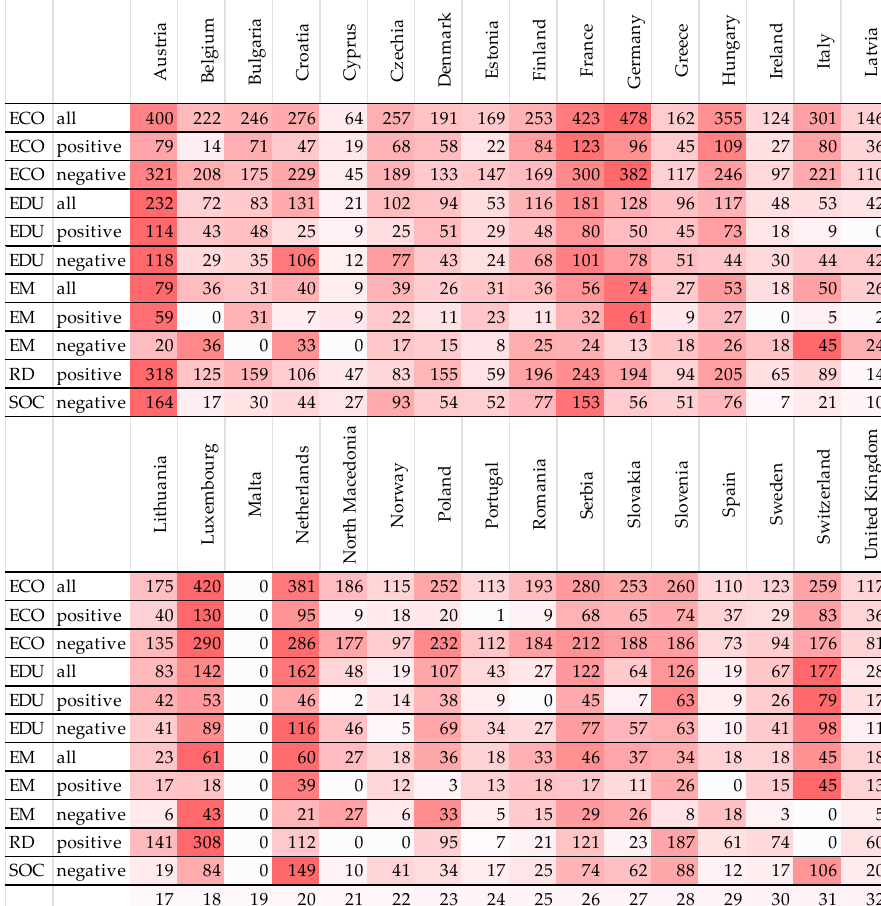
Figure 23. Number of precedence by country, first and long precedence group Soc by effect. Geospatial distribution.